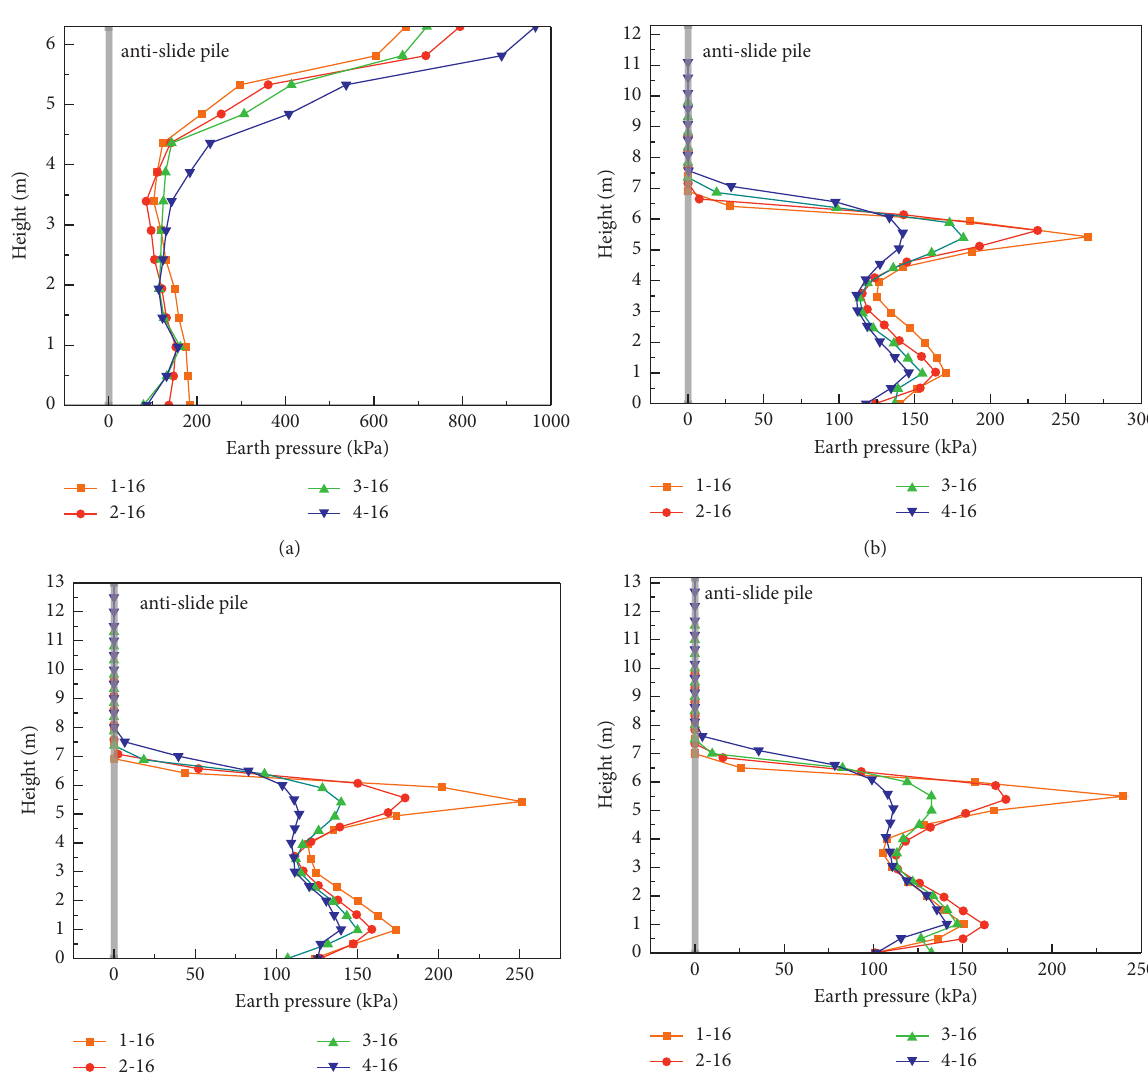
Figure 12: Earth pressure in front of pile: (a) P1; (b) P3; (c) P5; (d)